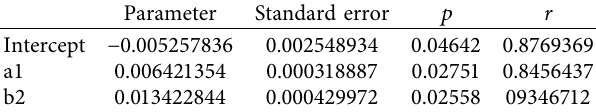
Figure 1: Exercise data collection of energy consumption pattern. Table 1: Linear regression analysis